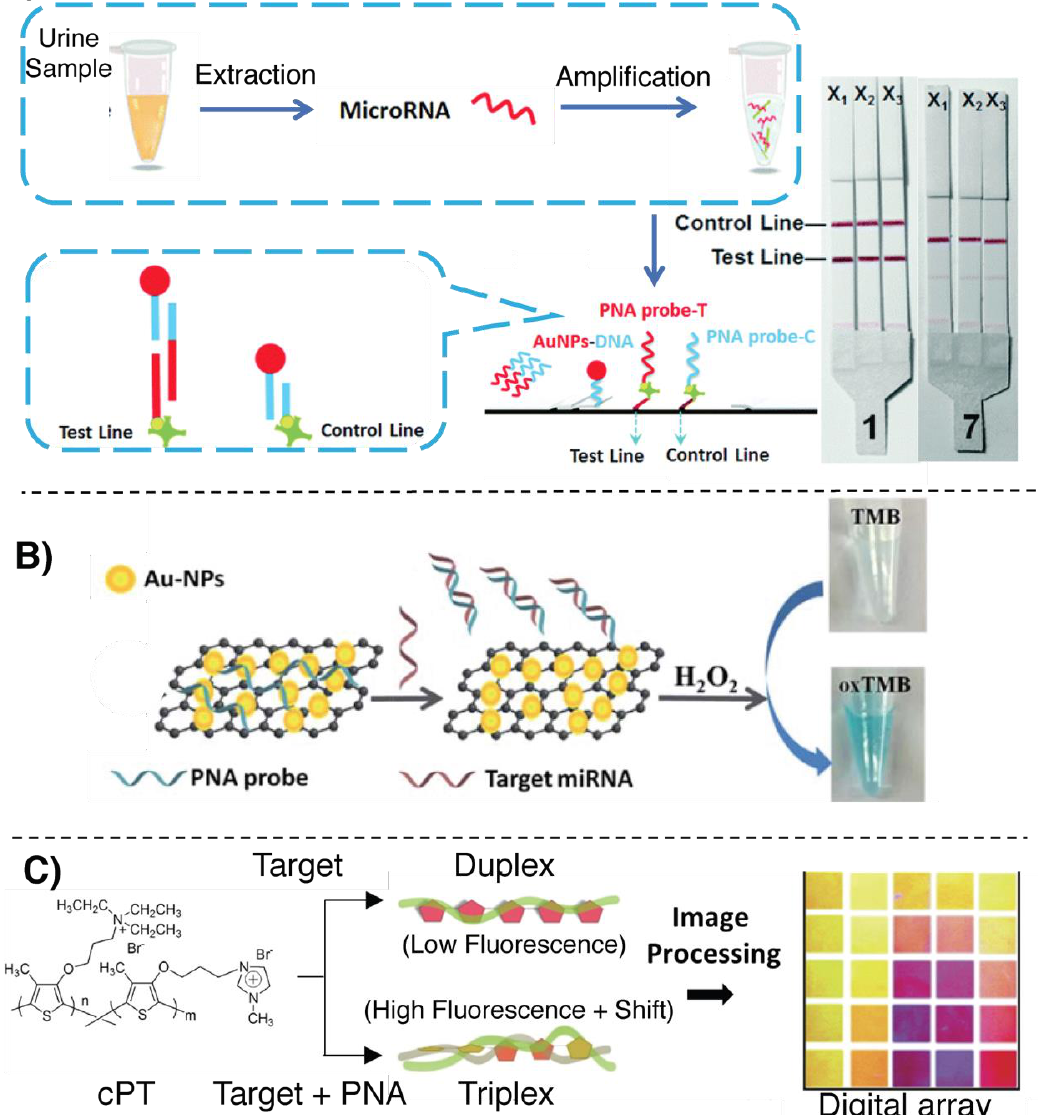
Figure 8. Illustration of some of the principal colorimetric methodologies for miR detection relying on PNAs. ( A ) Multiplexed, lateral flow strip detection of miR bladder cancer markers as illustrated in [103]. ( B ) Detection based on the peroxidase-like activity of graphene-AuNP nanohybrids shown in [107]. ( C ) Colorimetric / fluorescence-based detection of miR, relying on cPT:PNA:miR triplex formation, as described in [110].